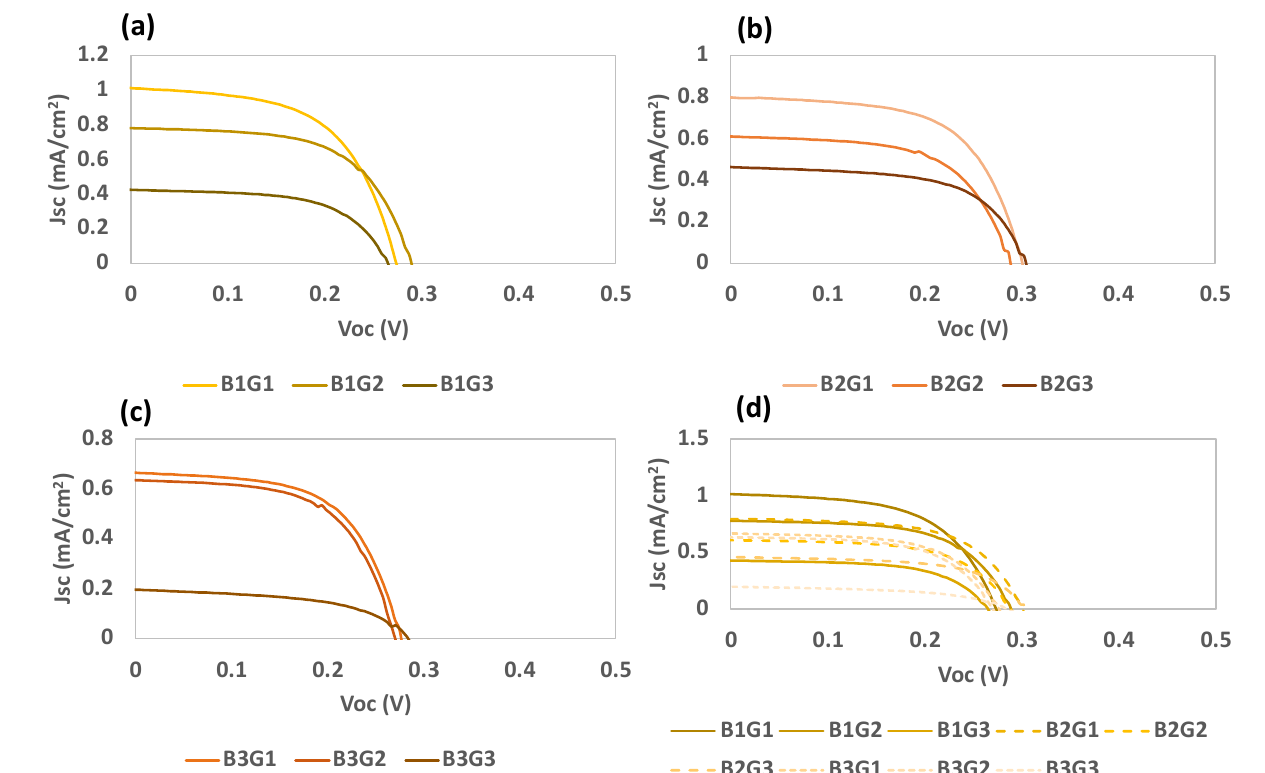
Figure 12. Photocurrent–voltage (J–V) curves of DSSCs based on RIO-60 as a dye replacement for the different batches, ( a ) Batch 1 (B1), ( b ) Batch 2 (B2), ( c ) Batch 3 (B3), and ( d ) all batches under simulated AM 1.5 G illumination at 100 mW/cm 2 .